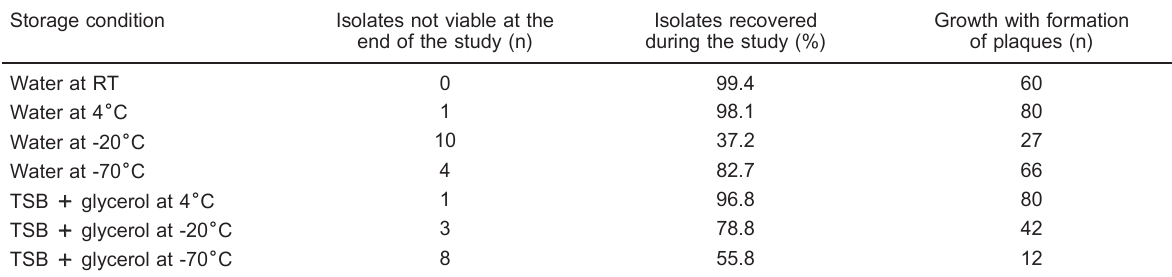
Table 2. Evaluation of the influence of different storage conditions on the maintenance of Pseudomonas aeruginosa isolates. Storage condition